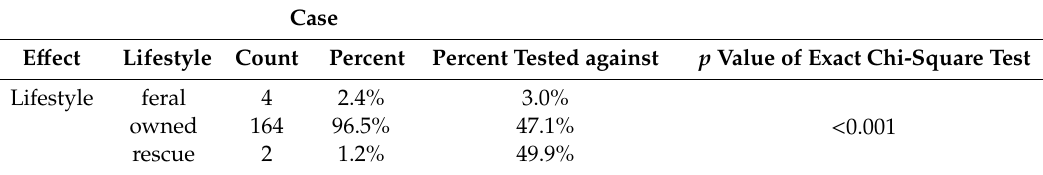
Table 5. Statistical analysis of lifestyle effect on acute cytauxzoonosis case incidence. Case